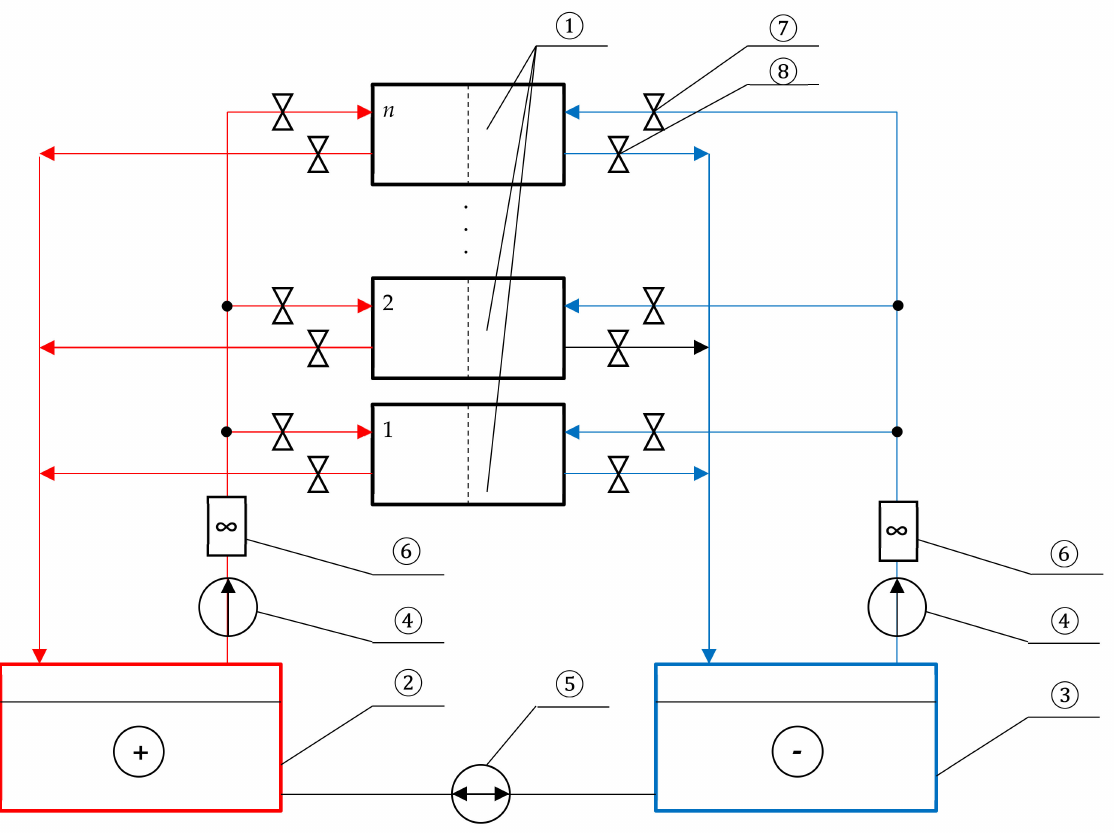
Figure 8. Hydrodynamic scheme for connecting multiple flow stacks: 1—VRB stack ( n pieces); 2